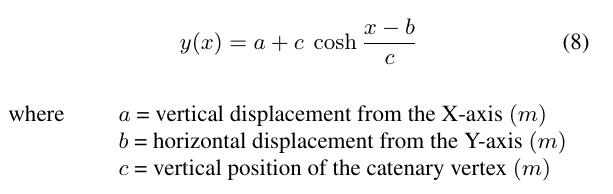
Figure 7. Results of the synthetic tests. catenary where the pylons are detected is shown in the example